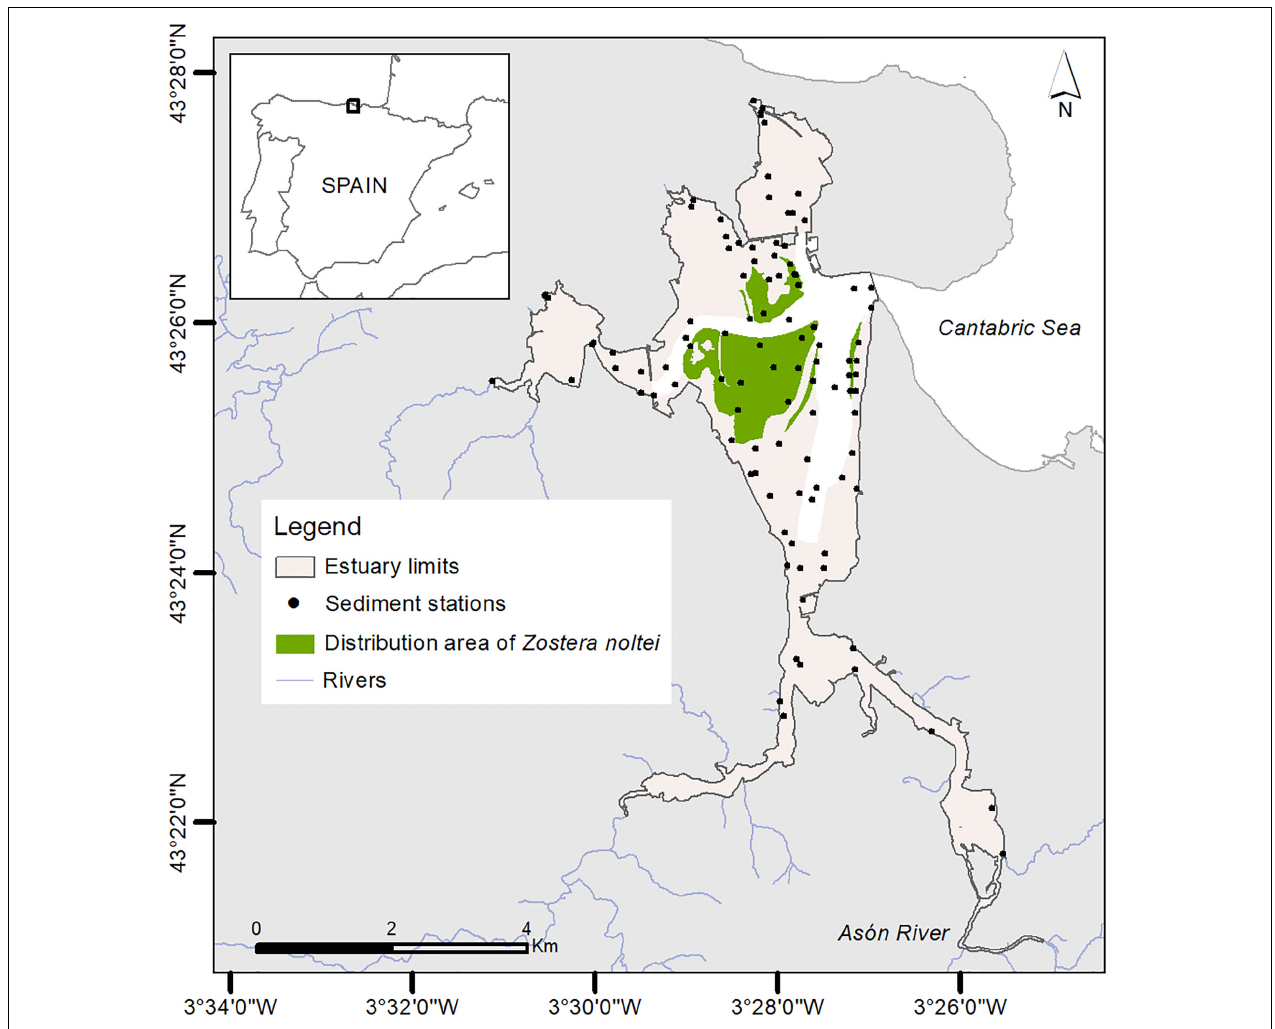
FIGURE 2 | Study site: location of Santoña estuary in the northern Spain. Spatial distribution of grain size sediment samples and distribution of seagrass meadows of Zostera noltei in